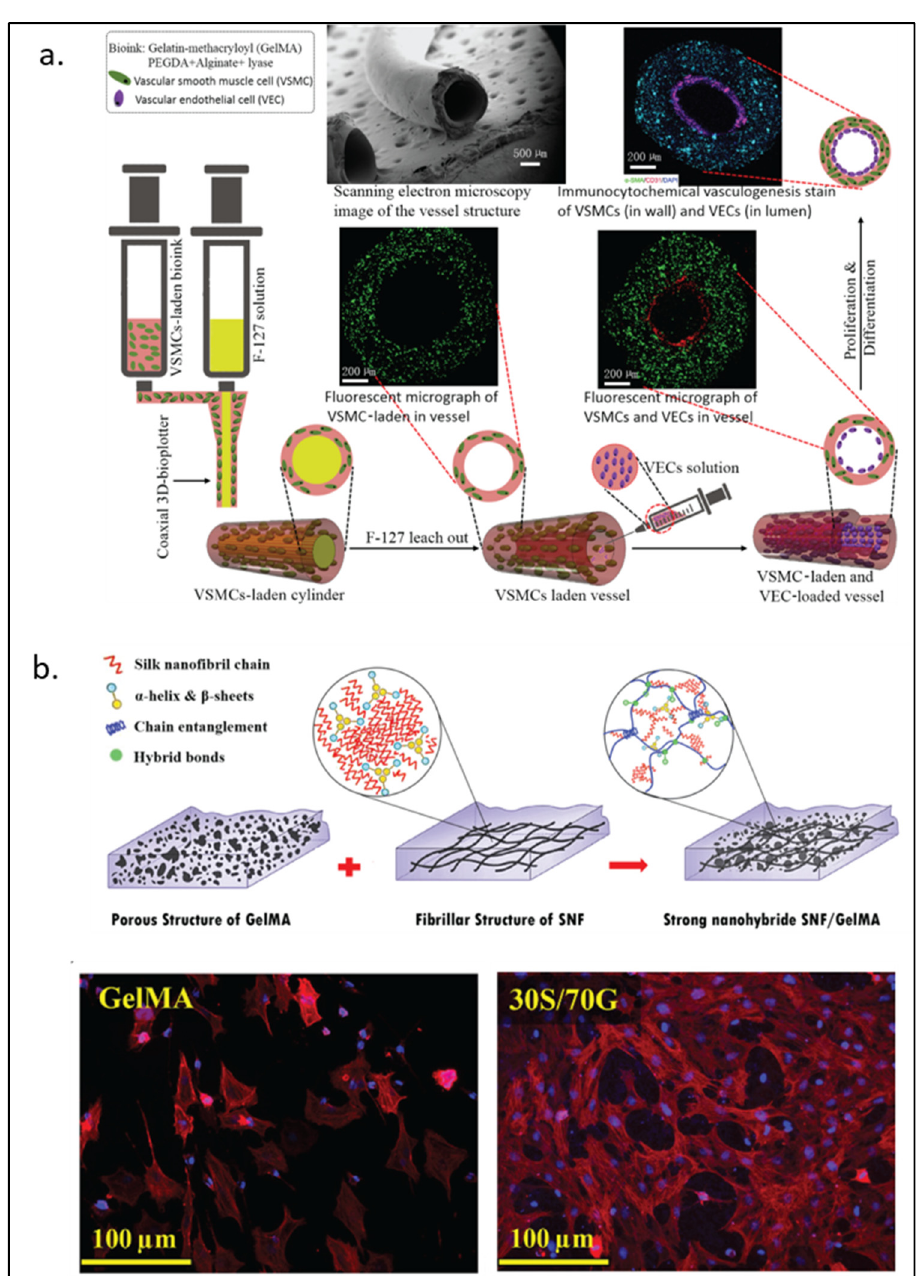
Figure 5. GelMA modified with naturally derived polymers. ( a ) Schematic representation of 3D- printed biomimetic blood vessels with alginate modified-GelMA. ( b ) Silk fibroin-modified GelMA for corneal regeneration with fluorescence imaging DAPI (blue) and rhodamine-phalloidin (red) after 5 days of culture. Reproduced (adapted) with permission from Ref. [42]. 2020 © ACS Applied Materials and Interphases; and Ref. [48]. 2021 © Material Science & Engineering C.